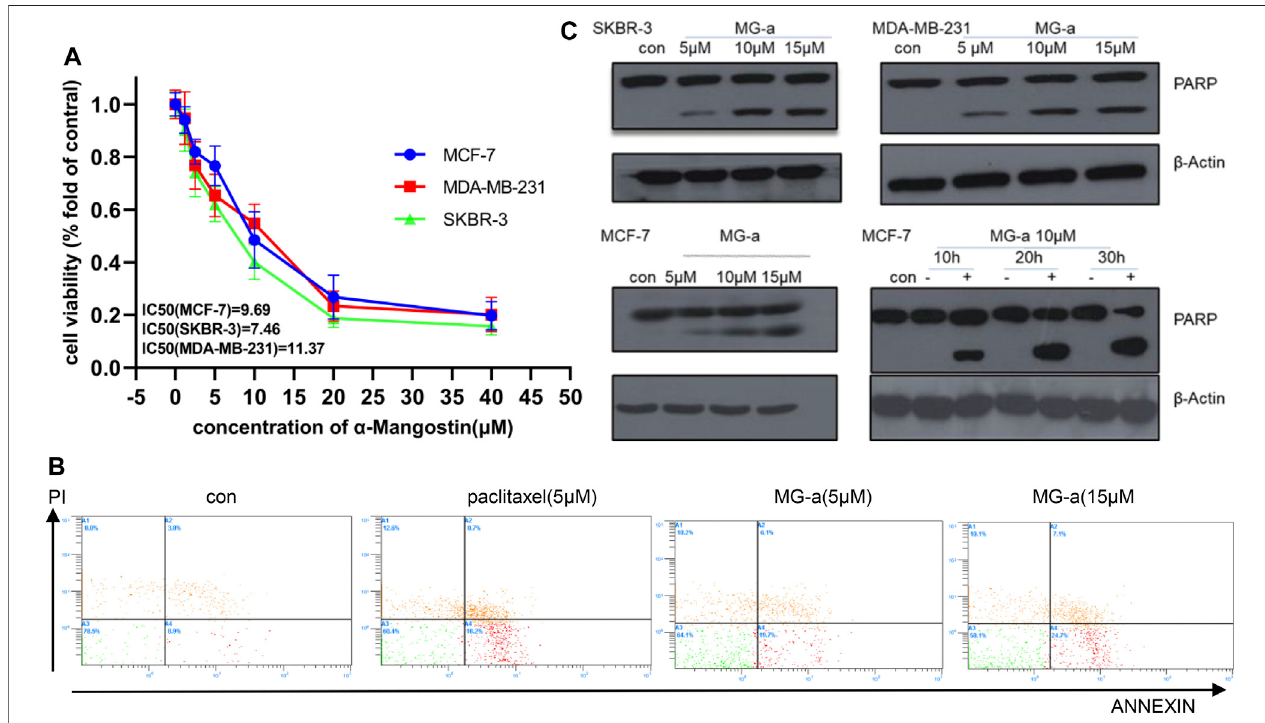
FIGURE 1 | α -Mangostin (MG-a) inhibits proliferation and induces apoptosis of breast cancer cells. (A) α -Mangostin reduces breast cancer proliferation. (B) ApoptosisofMDA-MB-231cells treatedwithMG-awasassessed by fl owcytometry. (C) PARPexpression levels weredeterminedbywesternblottinganalysisinbreast cancer cells after α -Mangostin